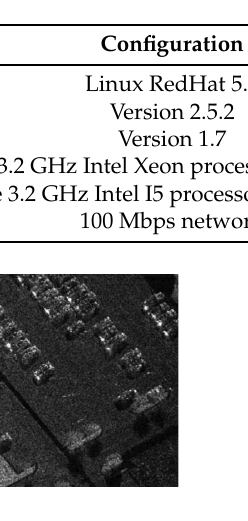
Table 1. Experiment configuration.